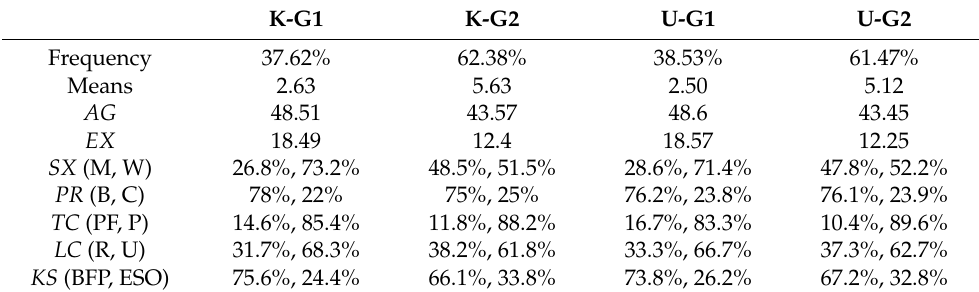
Table 13. Cluster groups as regards the knowledge and use of safety tools (SAF).